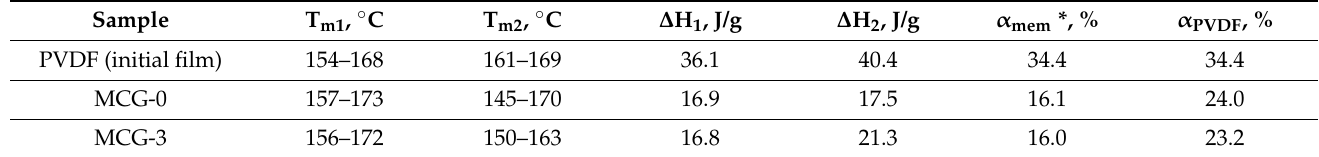
Table 3. Proton conductivity of the obtained membranes (mS/cm) at 30 °C and the different relative humidity.